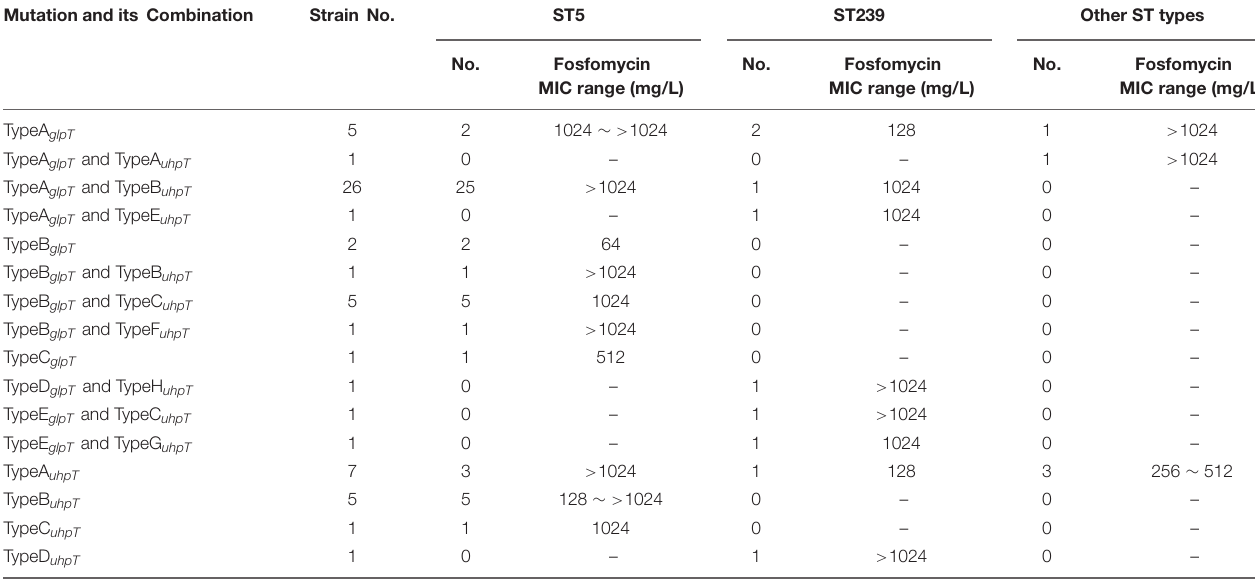
TABLE 4 | Characteristics of fosfomycin-resistant MRSA isolates contained glpT and uhpT mutations. Mutation and its Combination Strain